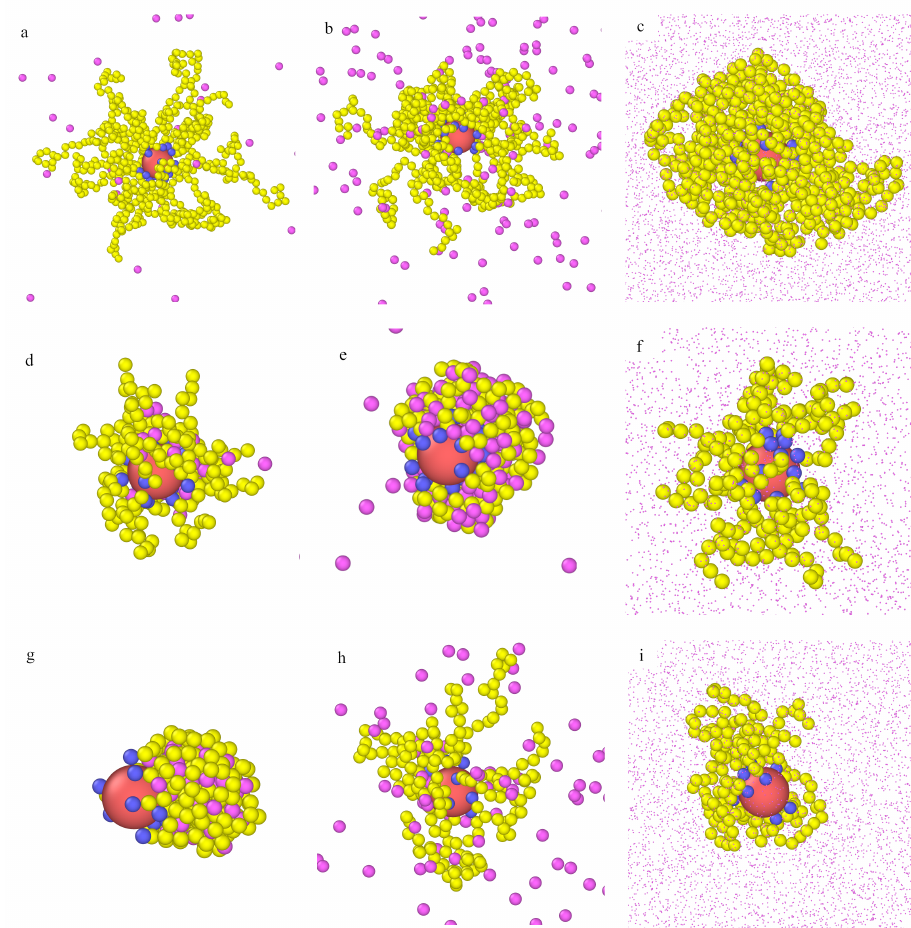
Figure 4. Examples of the equilibrium configurations of hairy particles (model M1, ε Ps = 1.5 ε ) immersed in fluids of different densities ρ 0 = 0.0001 ( a , d , g ), 0.001 ( b , e , h ) , 0.1 ( c , f , i ) for f = 20 and M = 20 ( a – c ), f = 20 and M = 10 ( d – f ), and f = 10 and M = 20 ( g , h , i ). The red sphere represents the core, and blue spheres correspond to bonding segments, yellow spheres and pink spheres represent the remaining segments and fluid particles P, respectively. For clarity, the particles P are represented by points (size ratios are not kept) in parts ( c , f , i